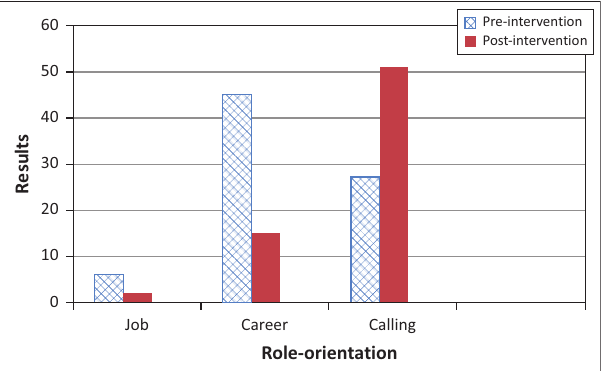
FIGURE 2: Extrinsic (explicit) level results.